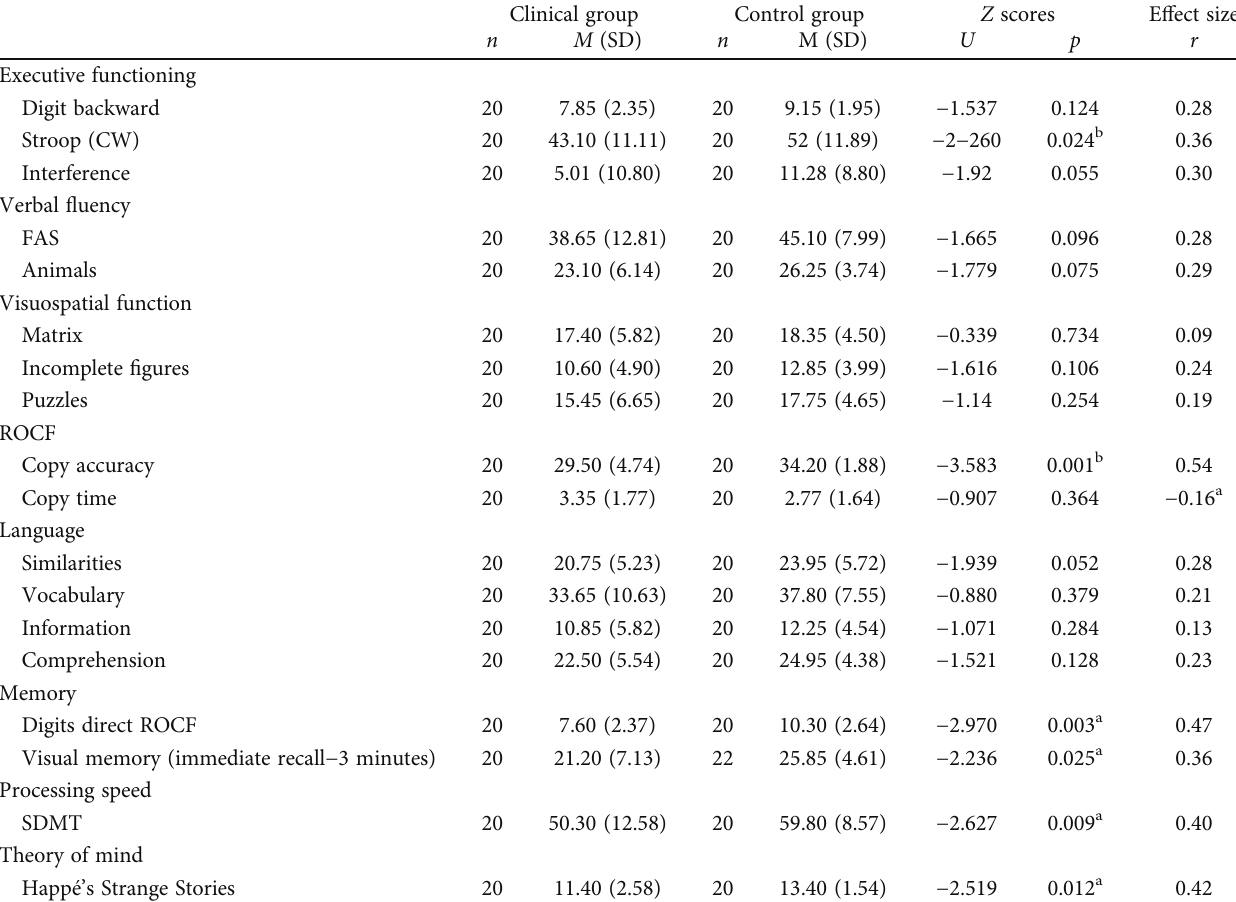
Table 2: Clinical and control group performance on cognitive